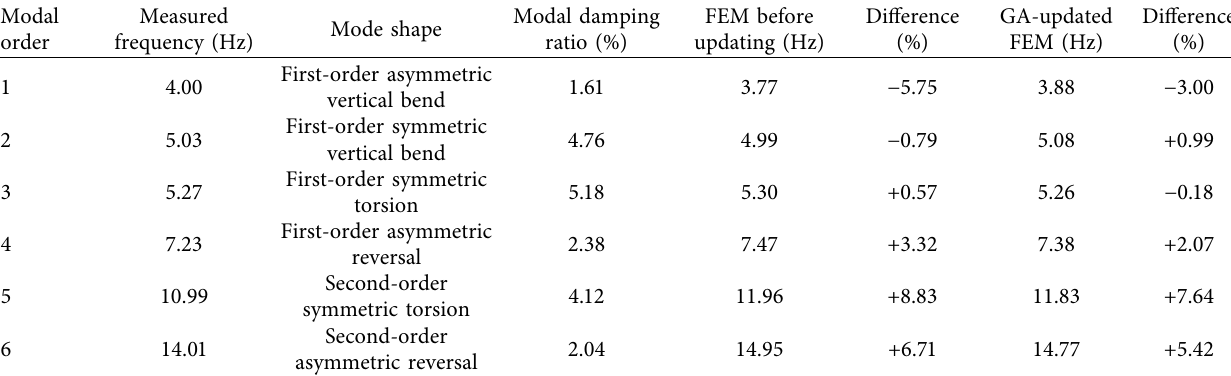
Table 5: Comparison of results before and after modal parameter